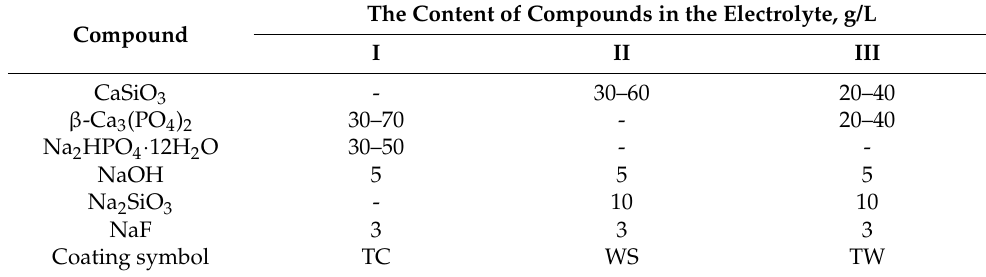
Coating symbol TC WS TW β -tricalcium phosphate ( β -TCP) (Germany) with a particle size of 1.5–5.0 µ m was used in the electrolytes number I(TC) and III(TW). Wollastonite MIVOLL ® 05-96 (ZAO GEOKOM, Kaluga, Russia) with a particle size of 20 µ m (average length) was added in the electrolytes number II(WS) and III(TW). β -TCP particles were isometric, while wollastonite particles were elongated (Figure 1). The elongated shape of the natural wollastonite particles was its characteristic feature and was due to the chain structure of the calcium orthosilicate [30,40]. The ζ -potential of powder samples was measured at a pH range of 6‒11 (ZetaSizer Nano ZSP, Malvern Instruments Ltd., Malvern, UK).